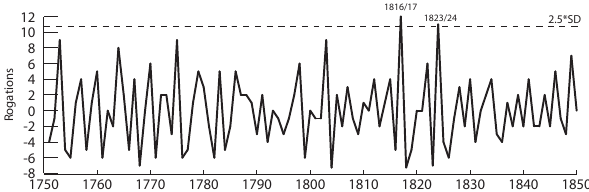
Fig. 7. Difference in the number of spring rogations between two consecutive